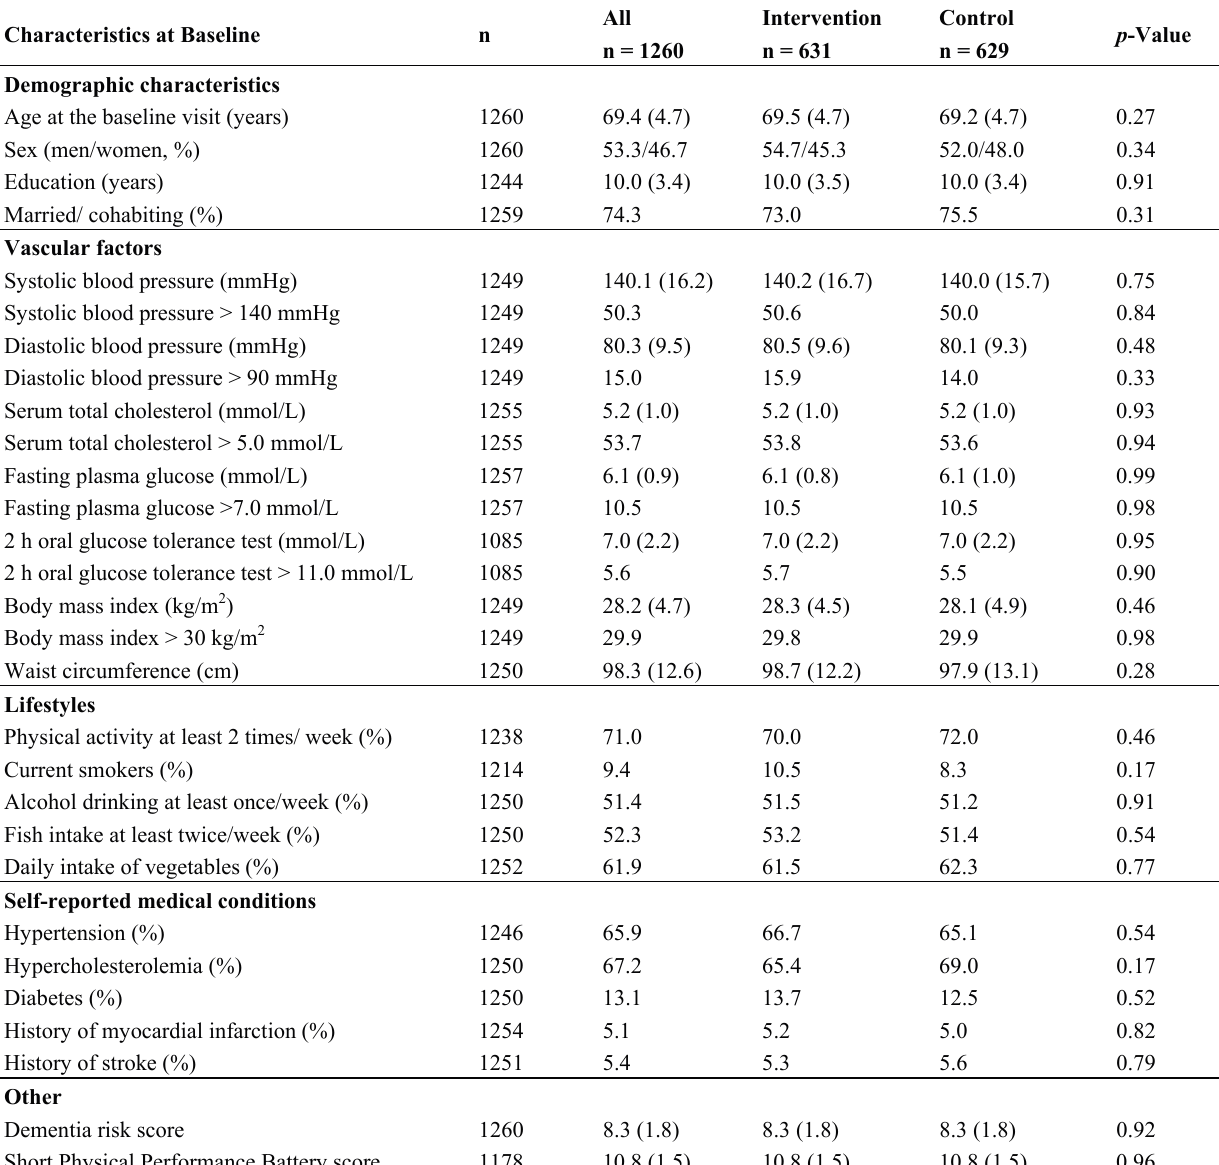
Table 3. Baseline characteristics of the persons who were randomized to the trial (mean (SD) or